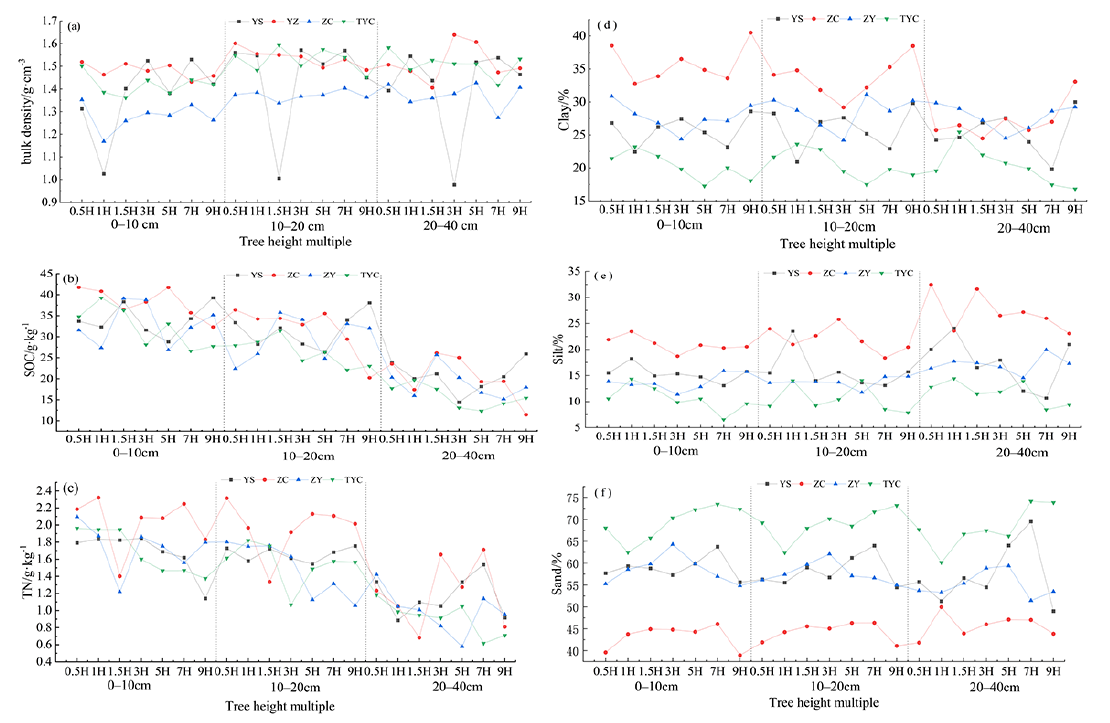
Figure 4. Changes in soil properties in the 0 – 10, 10 – 20 and 20 – 40 cm soil layers. Notes: ( a ) means Bulk density; ( b ) means SOC; ( c ) means TN; ( d ) means Clay content; ( e ) means Silt content; ( f ) means Sand content.